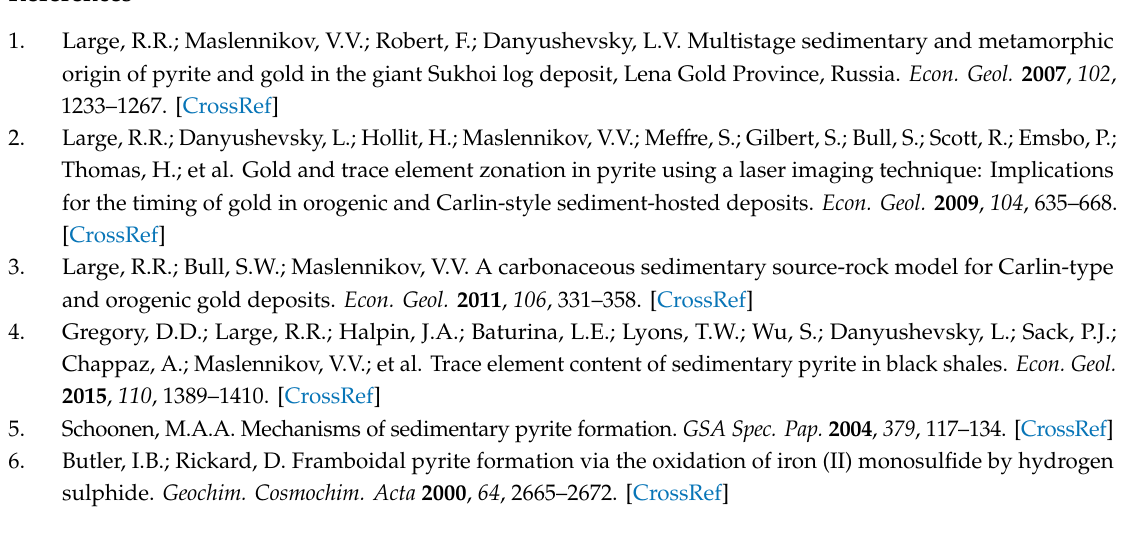
Table S1: Trace element composition of pyrite nodules according to LA-ICP-MS analyses and correlation matrices for pyrite and